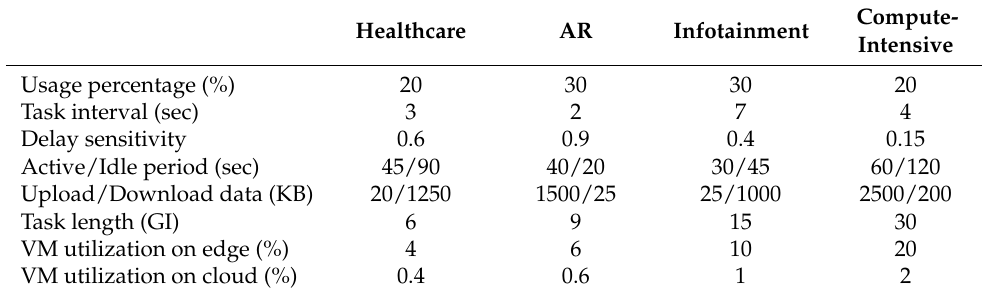
Table 6. Parameters of application types